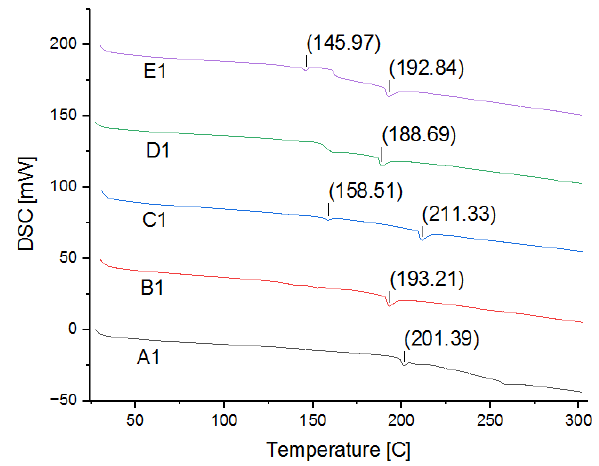
Figure 12. DSC test results for NaOH (A 1 ) 4%; (B 1 ) 4.5%; (C 1 ) 5%; (D 1 ) 5.5%; (E 1 ) 6%.